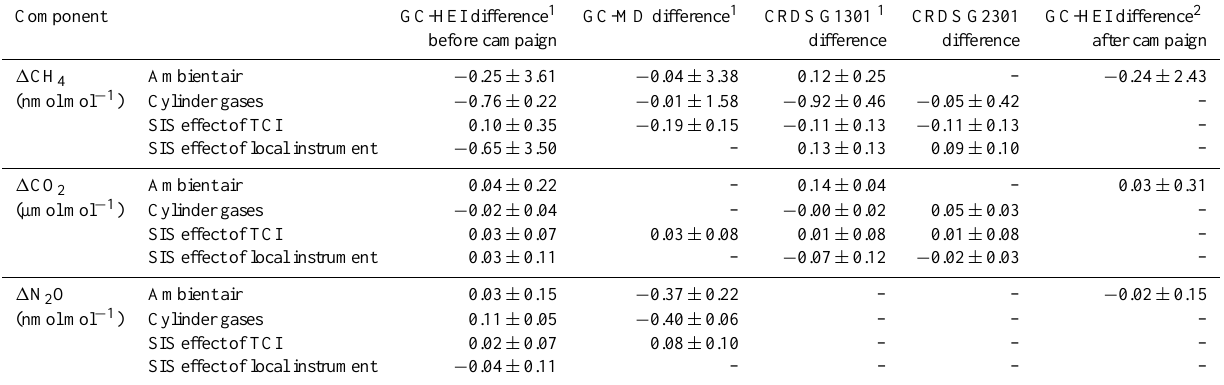
Table 1. Median differences and interquartile ranges between the ambient air measurements (local instrumentation – TCI), mean difference and standard deviation of direct cylinder gas measurements and SIS effects (SIS – direct measurement) of the GC-HEI and the TCI in Heidelberg (before and after the measurement campaign) and of the GC-MD, the CRDS systems and the TCI at Mace Head.